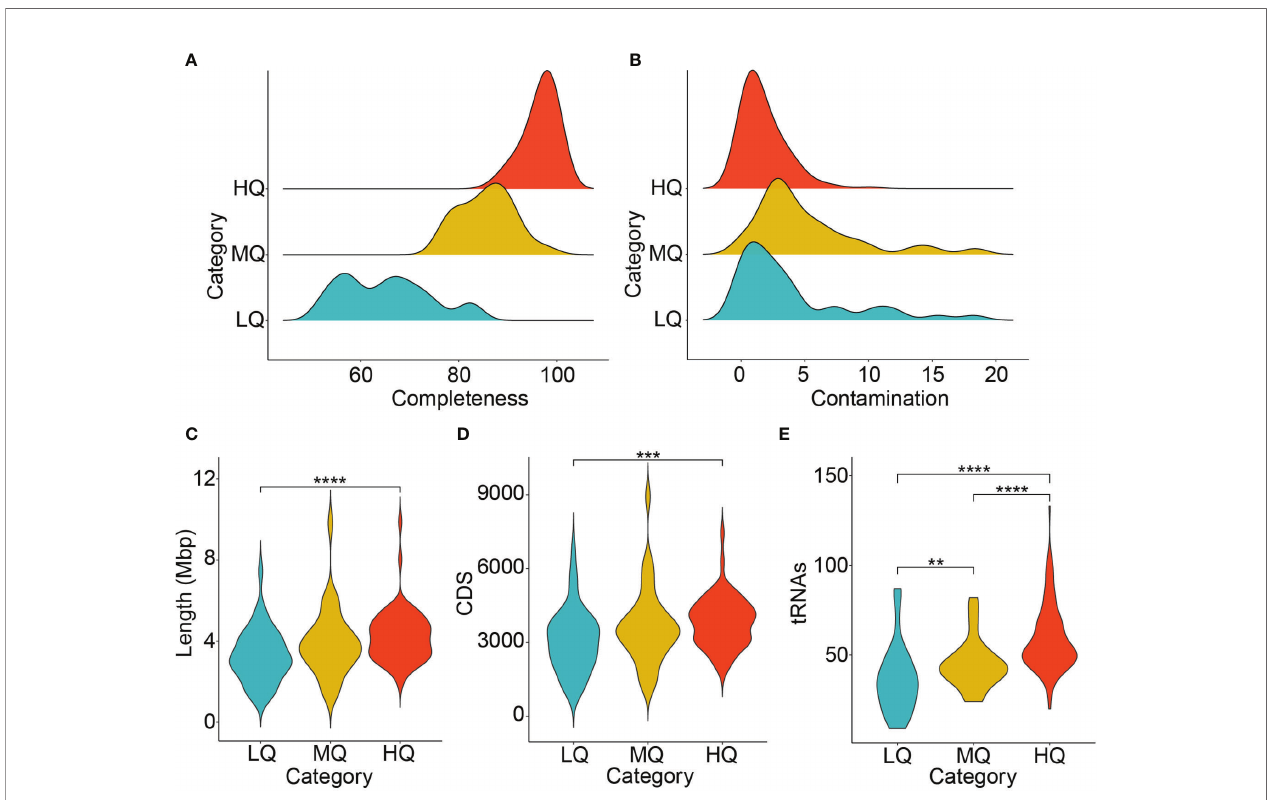
FIGURE 2 | General characteristics of the zebra fi sh stool microbiome. (A) Completeness (B) Contamination (C) MAG length (D) Coding sequences (CDS) and (E) the number of predicted tRNAs in the zebra fi sh stool MAGs are shown. The comparison among MAG lengths, CDS, and tRNAs in different MAG groups was performed using the Wilcoxon test, and P < 0.05 was considered statistically signi fi cant. **P <= 0.01; ***P <= 0.001; ****P <=